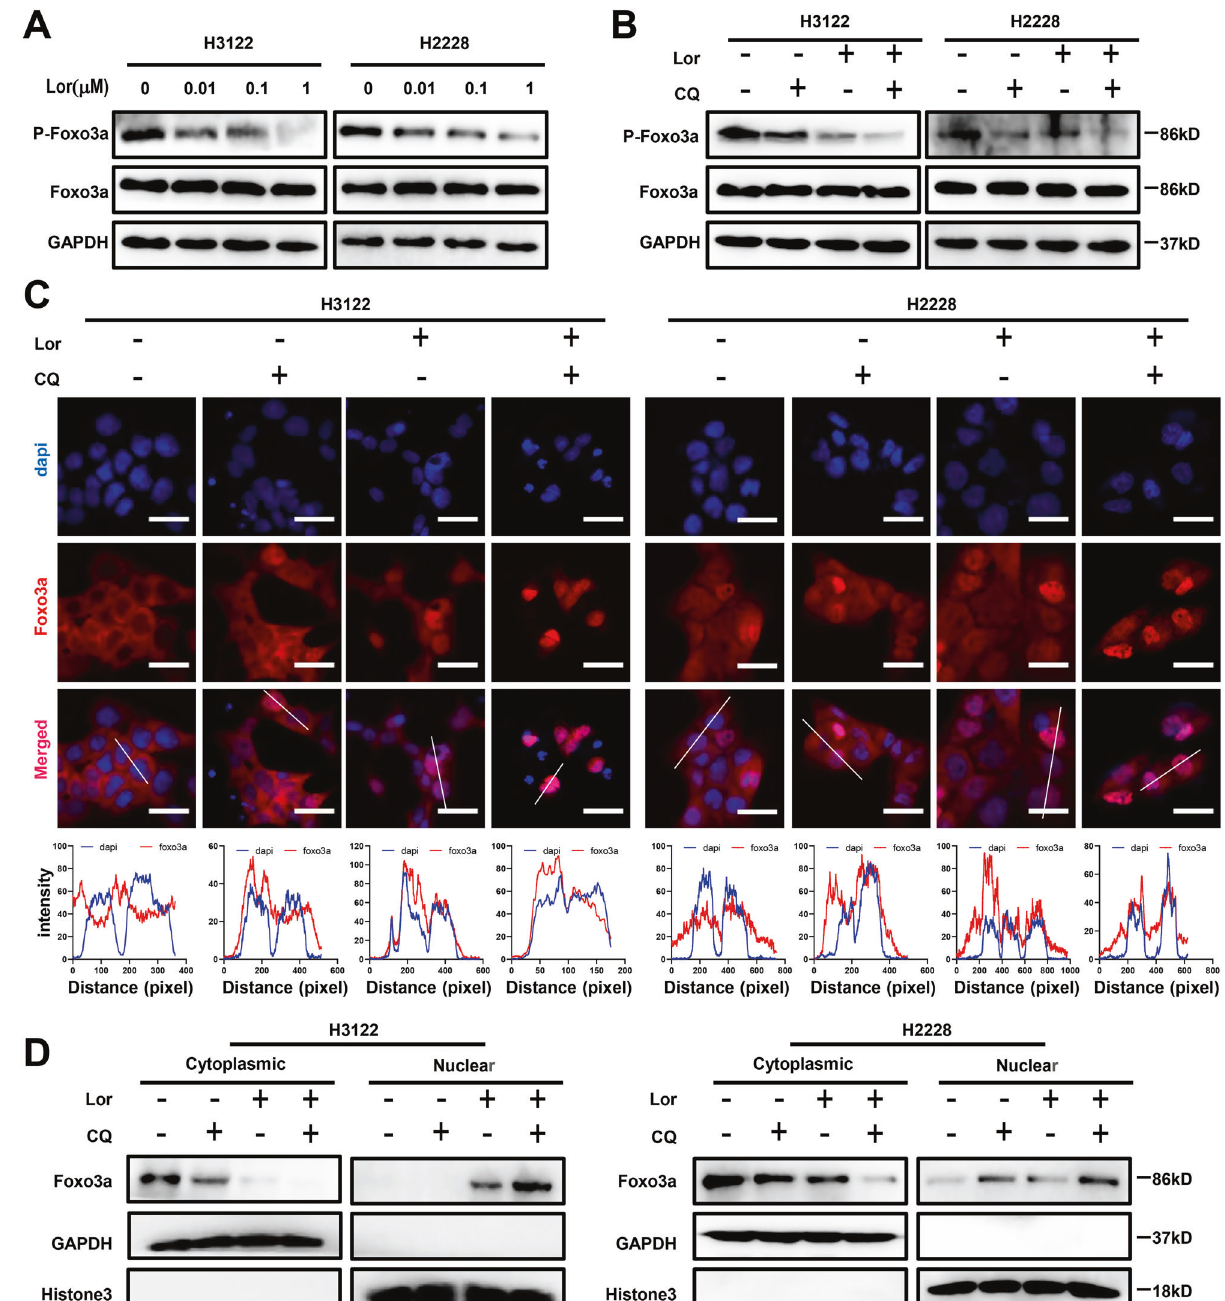
Fig. 4 Lorlatinib affects FoxO3a phosphorylation and nuclear translocation. A Western blot analysis showed that the phosphorylation level of FoxO3a decreased with the increase of lorlatinib concentration. B Co-treatment with lorlatinib (10 nM) and CQ (10 μ M) further decreased the phosphorylation level of FoxO3a. C Immuno fl uorescence staining showed that FoxO3a localized in the nucleus under lorlatinib treatment, while combined with CQ resulted in increased nucleus localization of FoxO3a. The nucleus was stained with 4 ′ , 6-diamidino-2-phenylindole. Plots of pixel intensity along the white line from the top and bottom rows of images were drawn below each plot. D The nuclear and cytoplasmic protein fractions from H3122 and H2228 cells treated with lorlatinib and/or CQ were immunoblotted with the indicated antibodies. Western blotting showed that whether in H3122 or H2228 cells, using CQ to inhibit the autophagy produced by lorlatinib can induce FoxO3a to shift from cytoplasm to nucleus. GAPDH and Histone3 were included as a loading control. Lor lorlatinib, CQ chloroquine. signi fi cantly increased in mice treated with the combination immunohistochemistry. Compared with any other group, the compared with mice treated with CQ or lorlatinib alone (Fig. 5G). expression of LC3 was signi fi cantly increased in the co-treatment Collectively, these fi ndings further suggested that the combina- with lorlatinib and CQ group (Fig. 5F). Western blotting was used tion of CQ and lorlatinib enhanced the therapeutic ef fi cacy in vivo, to detect protein expression in H3122 xenografts, and the results by inhibiting lorlatinib-induced autophagy and promoting showed that phosphorylation of Foxo3a was strongly inhibited, apoptosis. Bim expression was signi fi cantly elevated, and LC3 was further